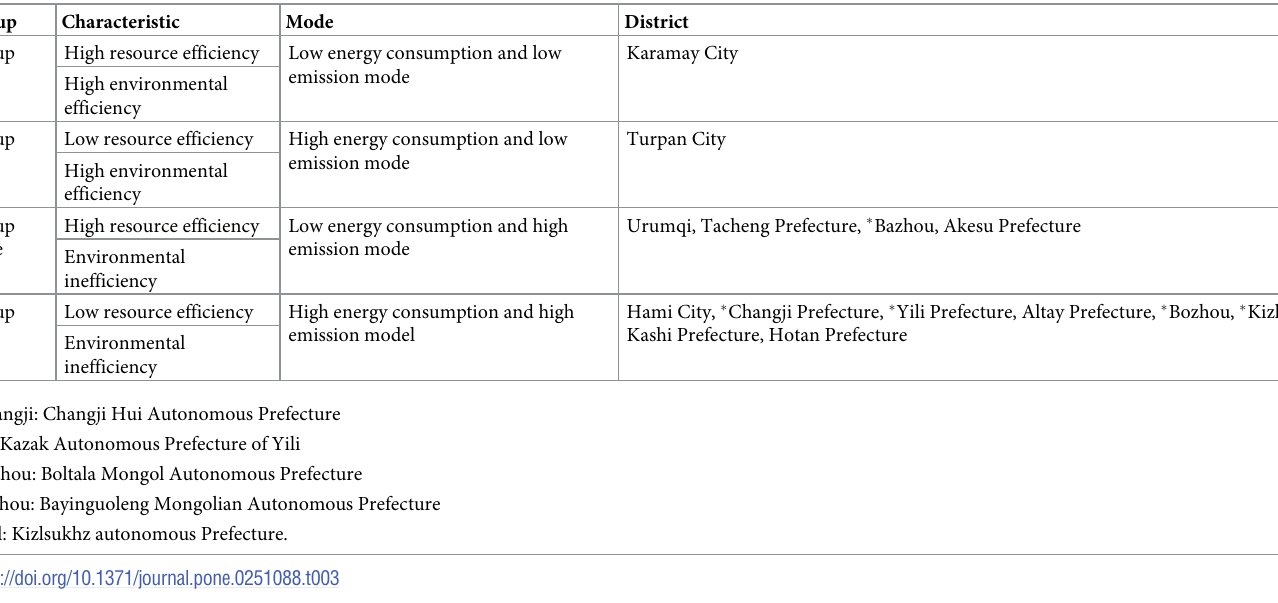
Table 3. Development modes and characteristics of different